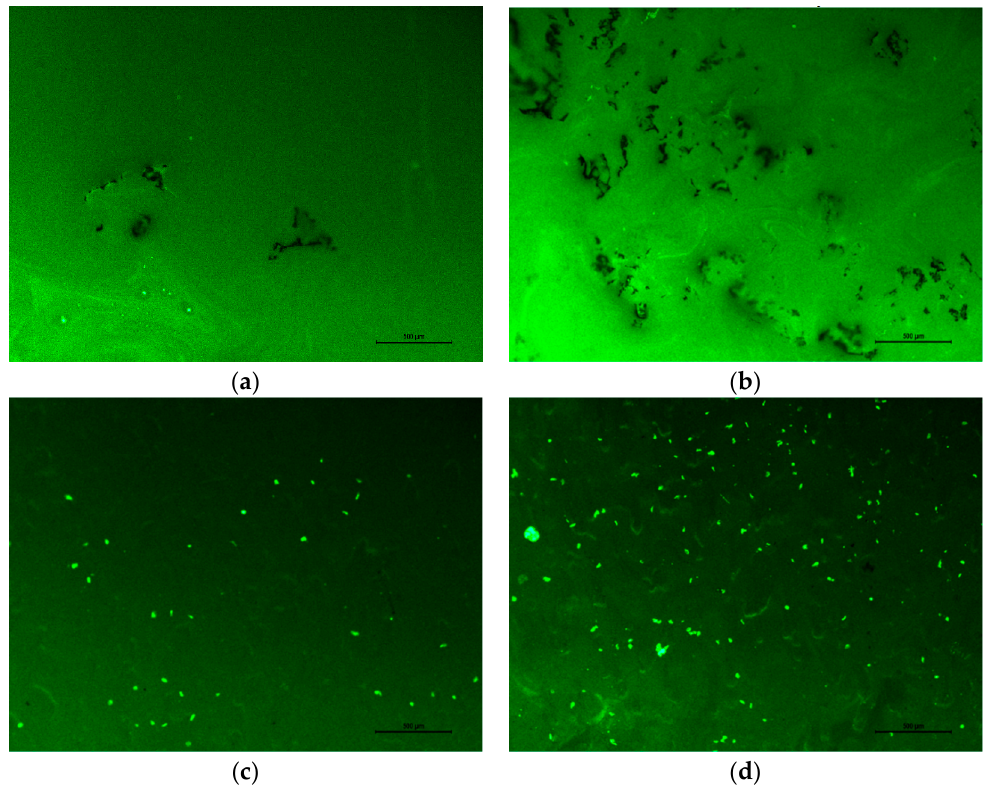
Figure 11. FM images of CRMA and A-G-R stored for 48 h. ( a ) The image of upper CMRA; ( b ) The image of lower CMRA; ( c ) The image of upper A-G-R; ( d ) The image of lower A-G- R.